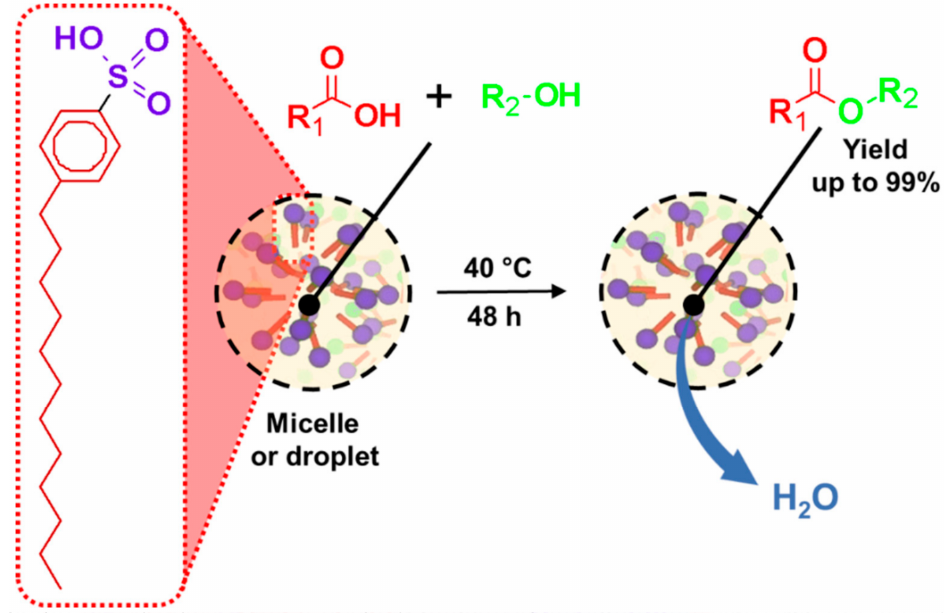
Figure 22. Brønsted acid − surfactant-combined catalyst, p -dodecylbenzenesulfonic acid, for esterification in a water